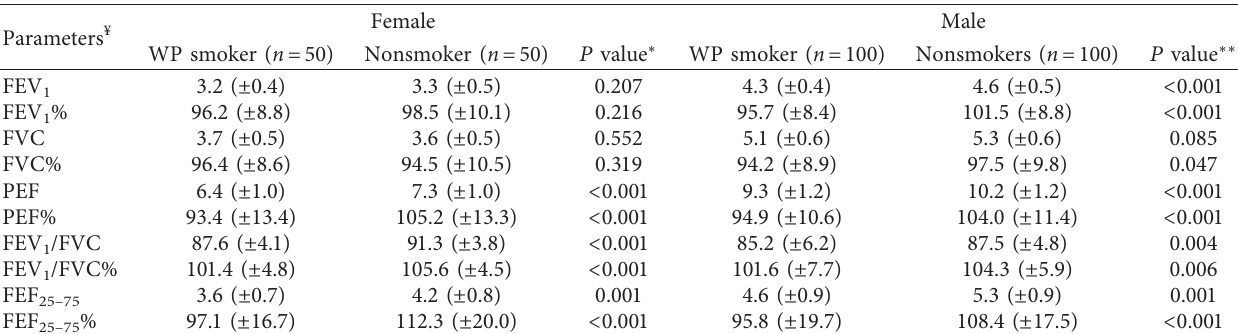
Figure 1: Comparison of spirometric parameters between waterpipe smokers and nonsmoker students. Values were presented as mean ± SD of FEV 1 %, PEF%, FEV 1 /FVC%, and FEF 25–75 % predicted. Table 3: Spirometry results comparing female and male waterpipe smokers and